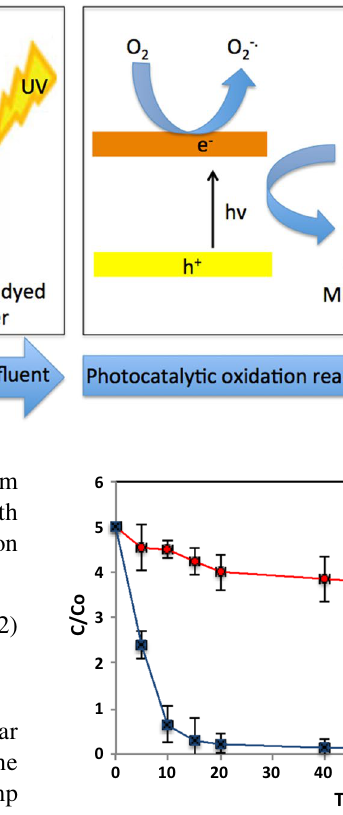
Fig. 1 Schematic illustration for the investigated setup